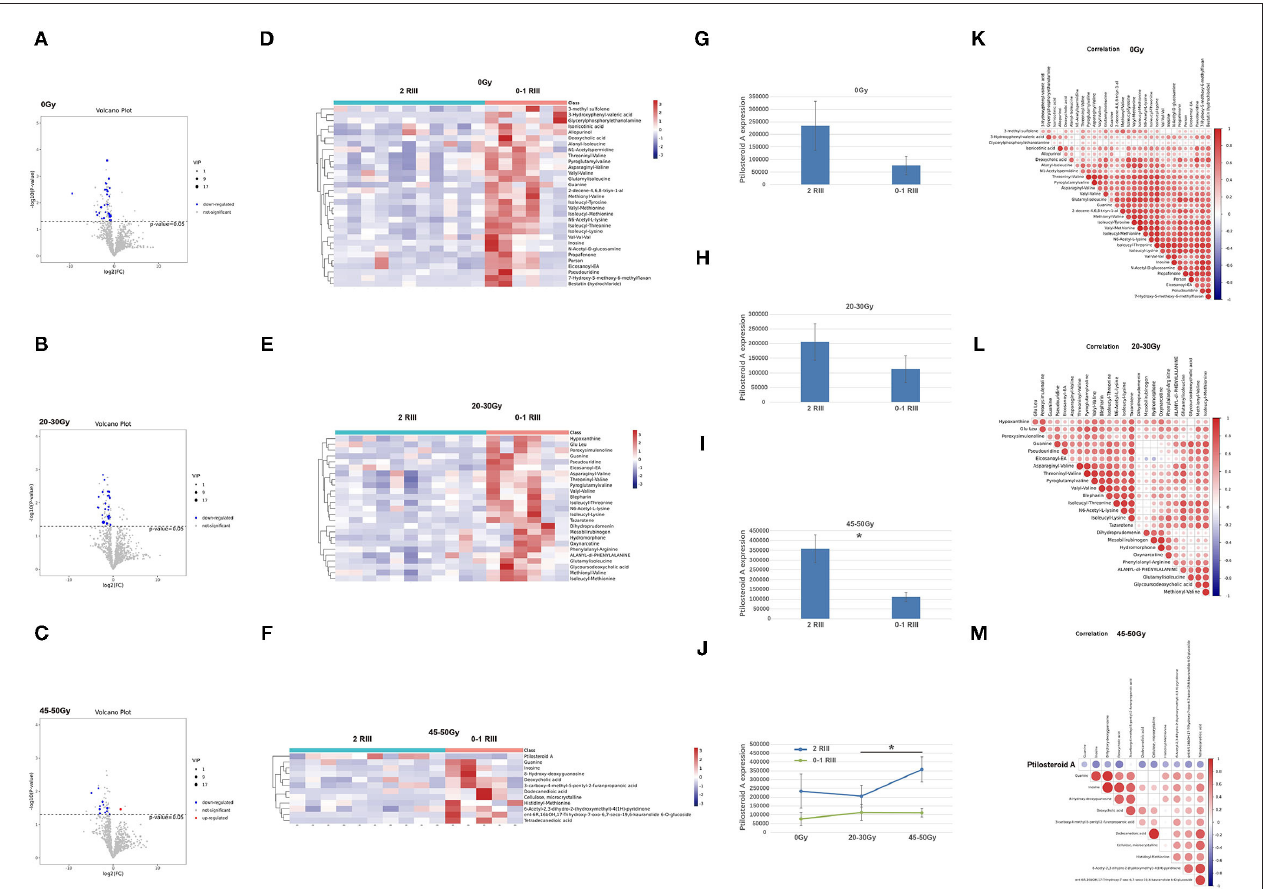
FIGURE 3 | Gut metabonomics in grade 2 RIII patients significantly differed from that in grade 0 or 1 RIII patients at all the three timepoints. (A–C) Volcano plot of the significantly differential metabolites. (D–F) Heat maps of the significantly differential metabolites. (G–J) Expression level of ptilosteroid A of the two groups. (K–M) correlations of the differentially expressed metabolites. The symbol * means the P value was smaller than